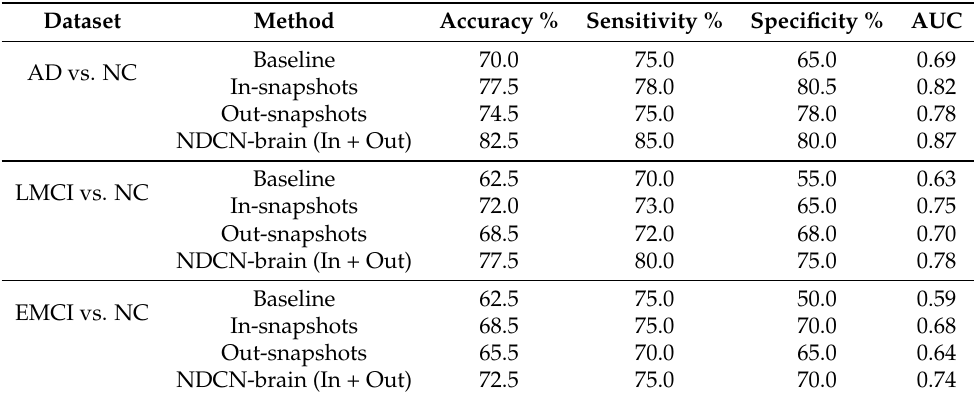
Table 8. The influence of in-snapshots and